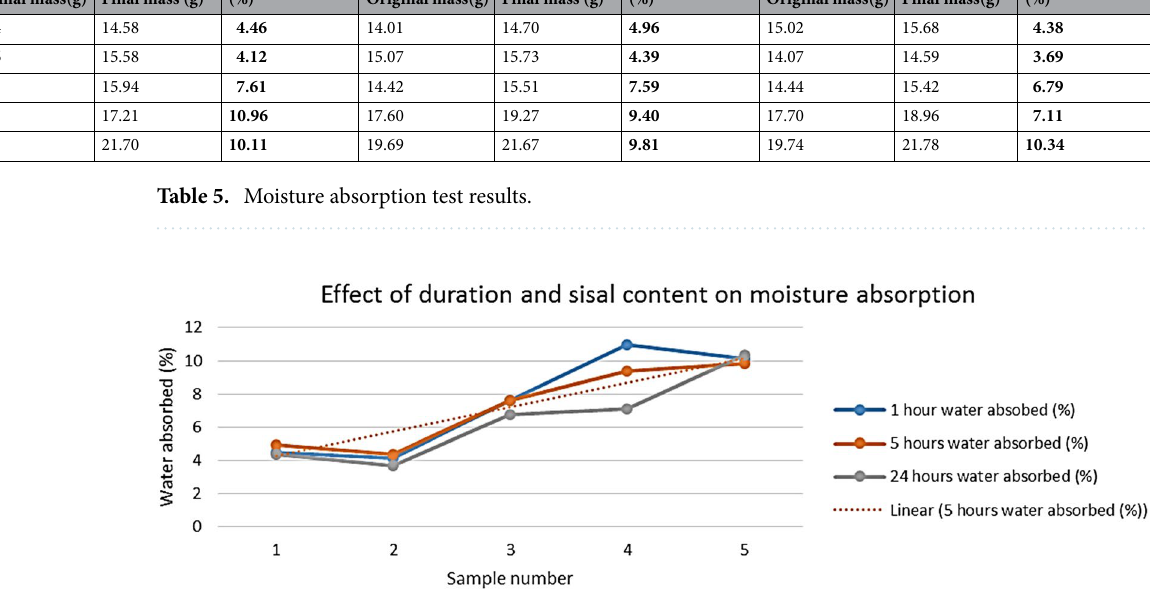
Figure 6. Effect of duration on moisture